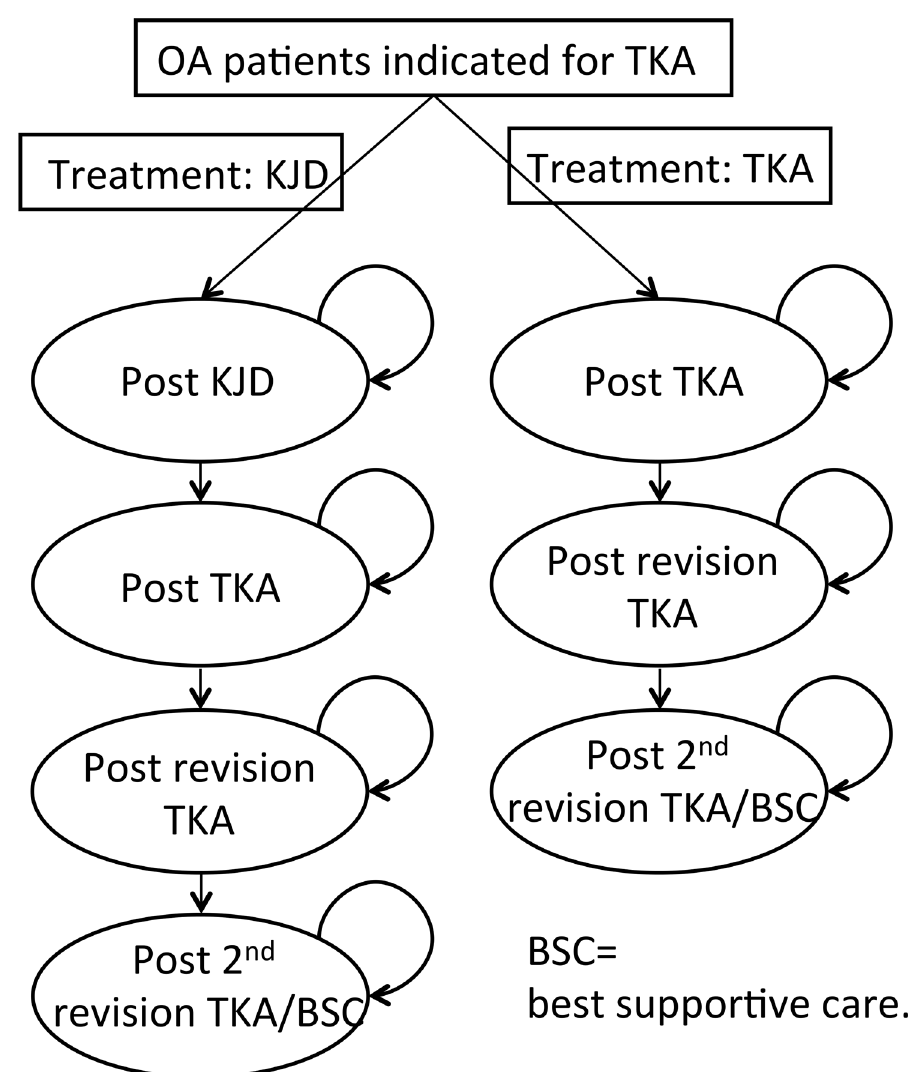
Fig 2. Overview of the health state model. Over the 20-year horizon analysis of the model patients are at risk of dying, so they can move to the absorbing state death from each other state. State death not shown in Fig BSC = Best Supportive